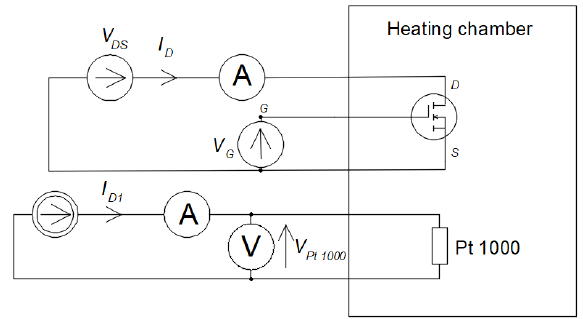
Figure 6. Electrical circuit that allows designation of the relationship between drain current I D and gate voltage V G .